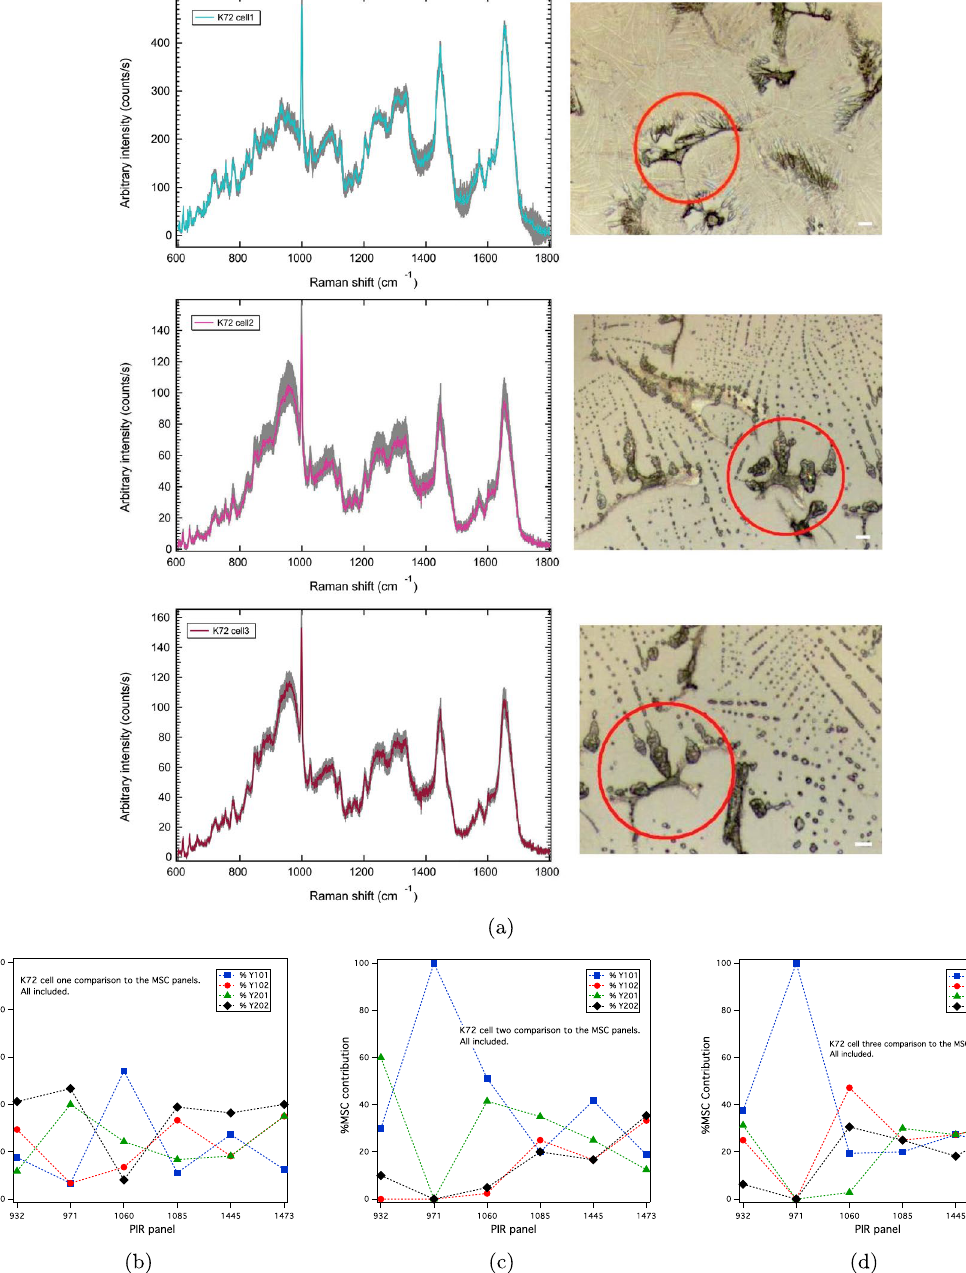
Figure 5. ( a ) Average fingerprints comprising 36 spectra/individual cell map for each of the primary K72 cells circled in the corresponding optical images (cells 1, 2 and 3, respectively). Scale bar = 20 µ m. ( b )–( d ) KNN-classified, % hTERT MSC contributions associated with each individual cell as determined across all PIR − 1 markers for each individual panel (Figs. S9–S11). For the 971 cm panel, which stratifies cell-type, the K72 cell 1 is most closely matched at 53% to the Y102/Y202 cell-lines. The K72 cells 2 and 3 have 100% matches against Y101. Assessed across all panels and markers, the K72 cell 1 has an overall 58% match against the Y102/Y202 cell-lines, with K72 cells 2 and 3 having overall Y101/Y201 dominance at 73% and 55% matches, respectively (Table